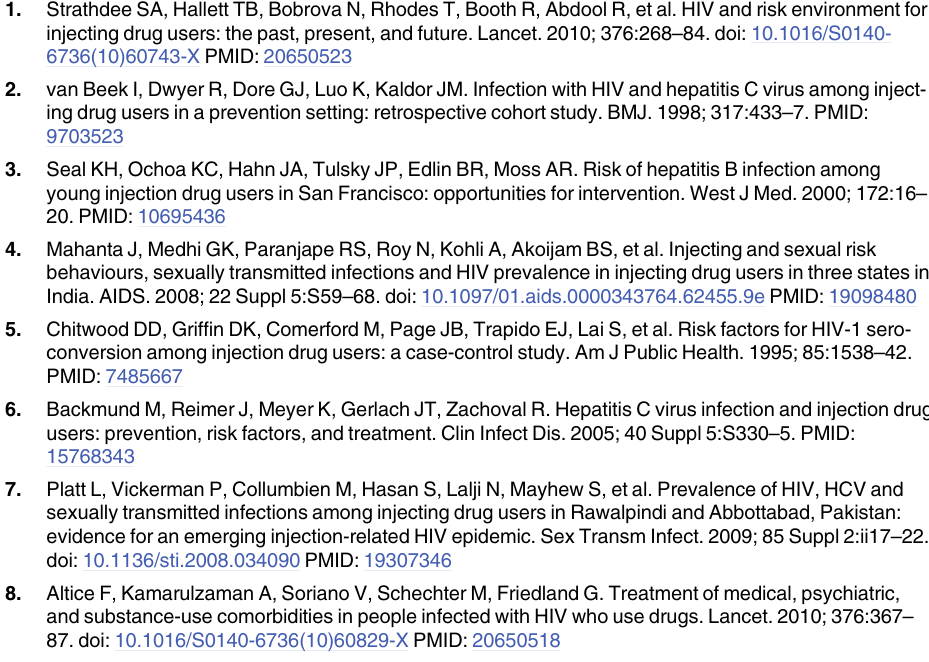
S1 Table. Sociodemographic characteristics of participants stratified by integrated MAT